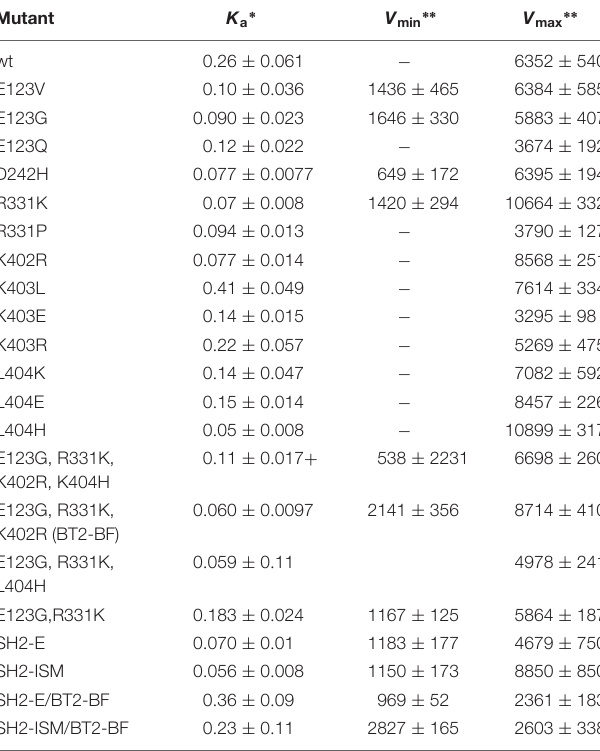
TABLE 3 | 3-PGA Ka values and activity in the presence and absence of 3-PGA in Bt2 variants with substituted amino